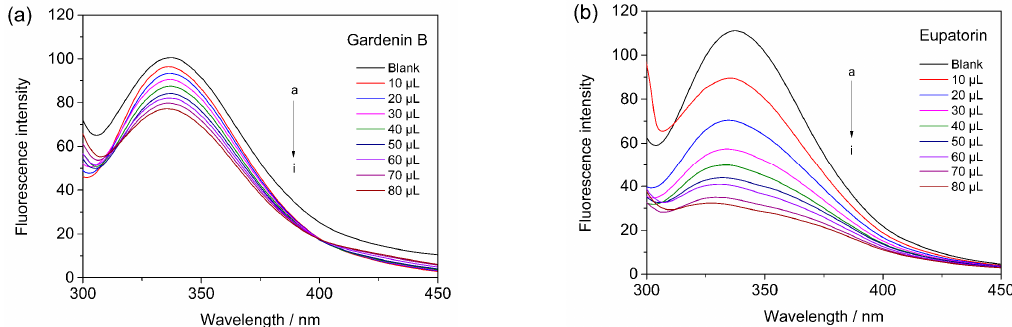
Figure 8. The quenching effects of ( a ) gardenin B and ( b ) eupatorin on xanthine oxidase (XO) fluorescence spectra at 300.15 K. λ ex = 280 nm; XO, 1.0 μ mol/L; the addition of gardenin B was from